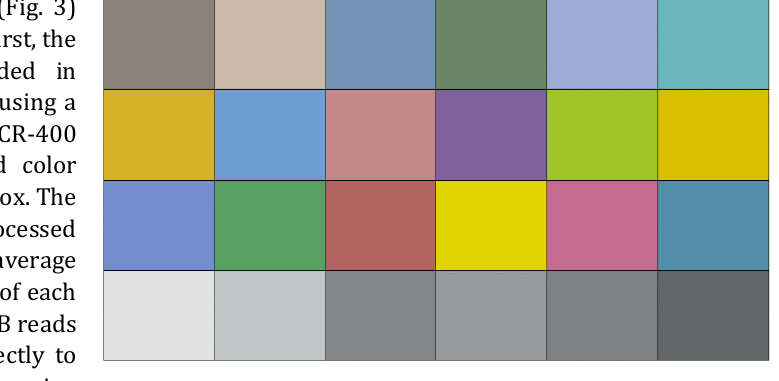
Figure 3. The standard color chart used in the system standardizing.